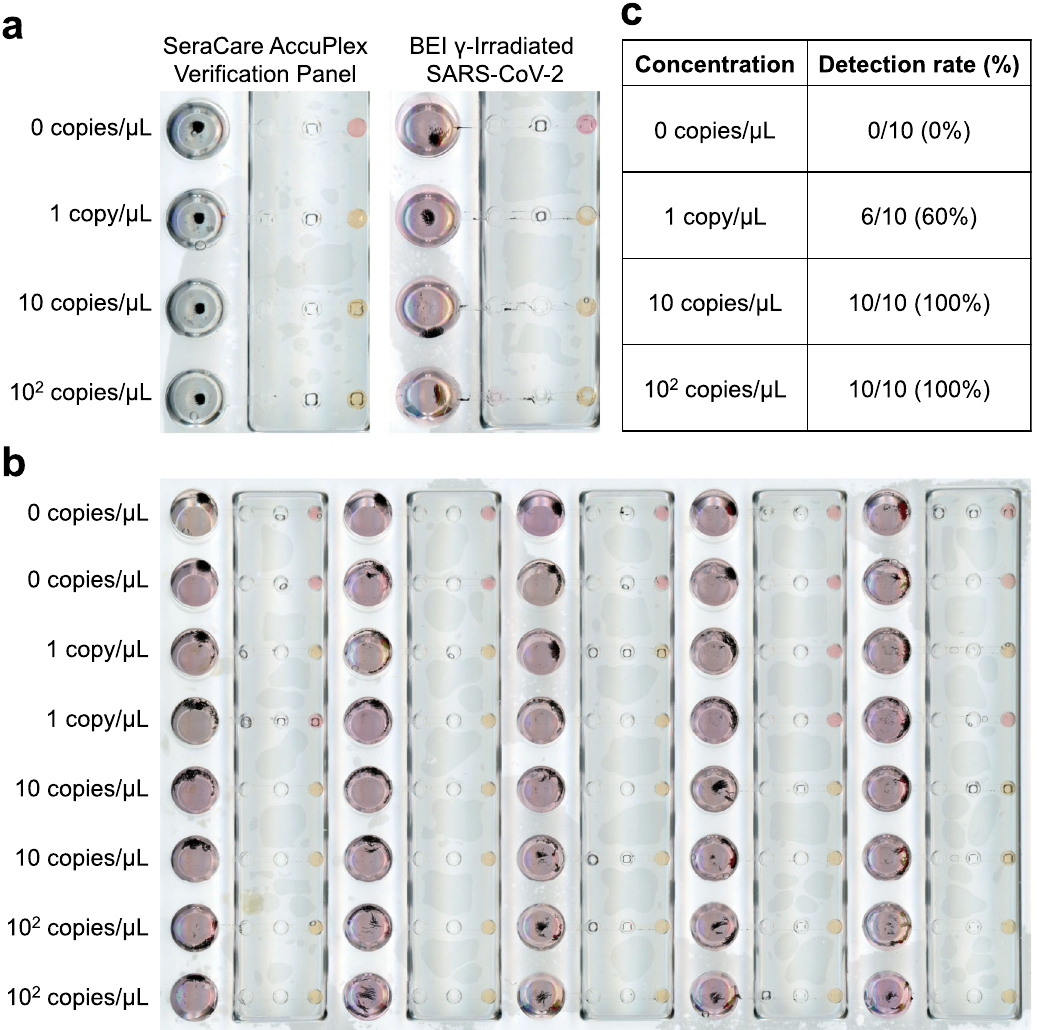
Fig. 4 Extraction and detection of contrived SARS-CoV-2 viral particle samples using OIL-TAS. a RNA extraction and detection of viral particles. Left, synthetic viral particles containing SARS-CoV-2 consensus sequences (AccuPlex veri fi cation panel, SeraCare Life Sciences Inc.). Right, γ -irradiated inactivated SARS-CoV-2 particles (strain USA-WA1/2020) from BEI. b Sensitivity of the OIL-TAS assay for detecting SARS-CoV-2 viral particles across 10 replicates. c Detection rate of the OIL-TAS assay across different viral particle concentrations (quanti fi ed from panel b ).